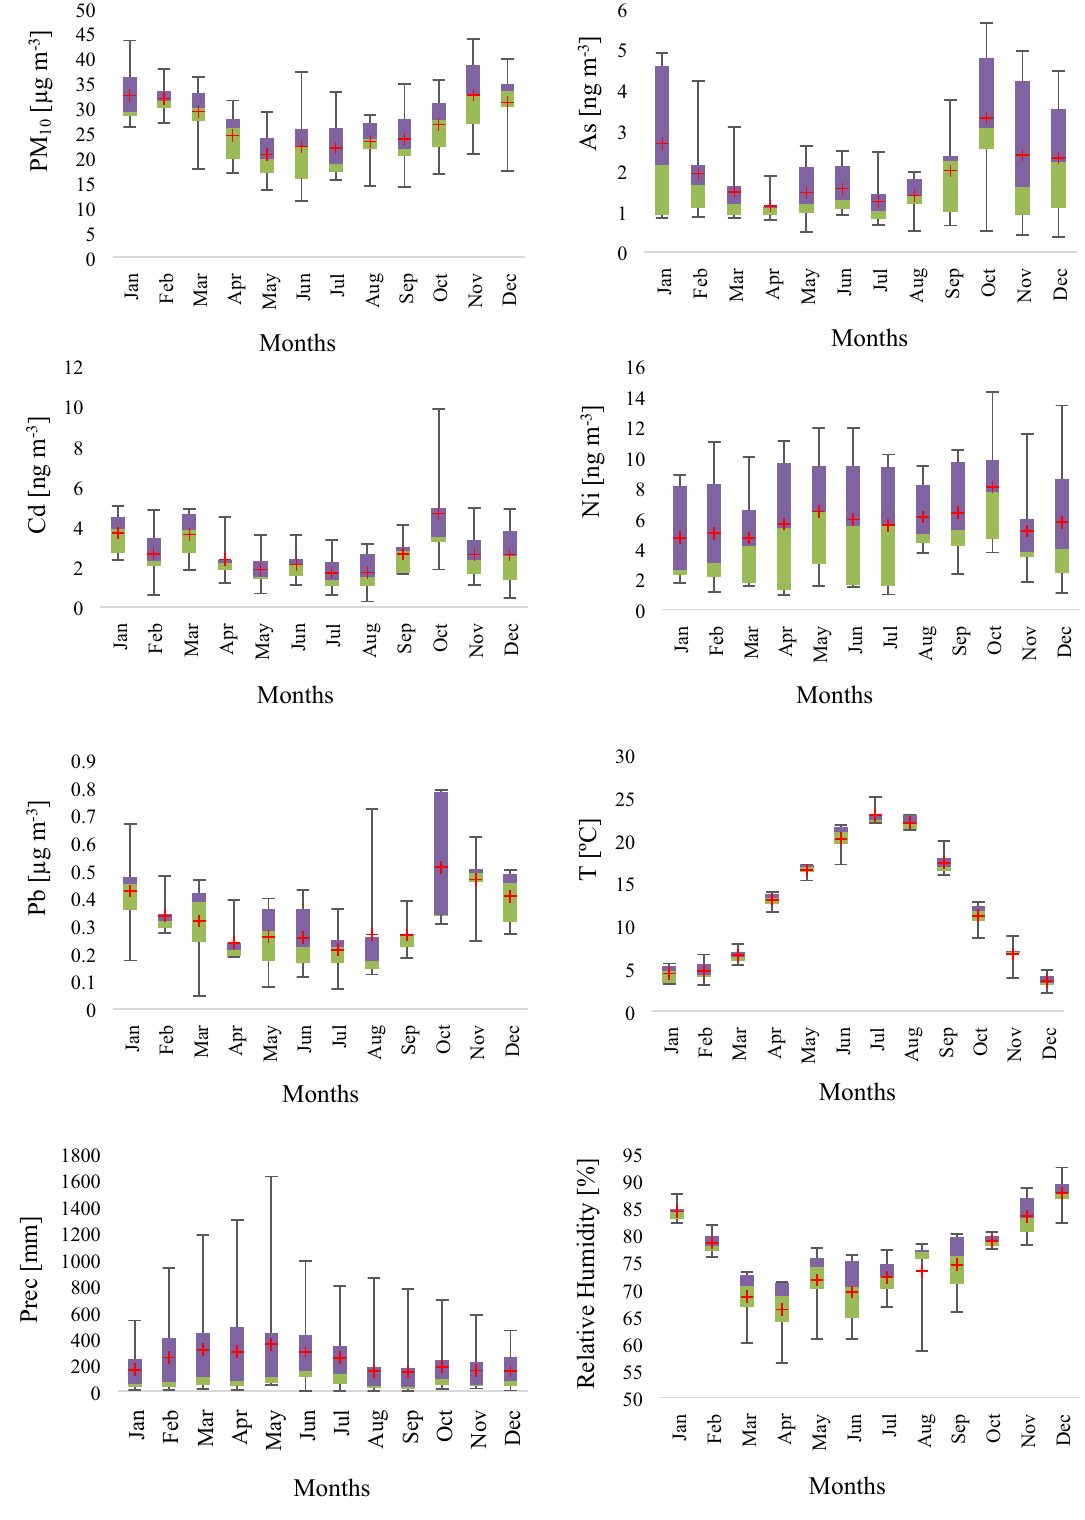
Figure 1. Box-plot analysis of multiannual monthly variations of pollutants and meteorological parameters. The lower (green) and upper (purple) limits represent the first (25P) and third (75P) quartiles, means are represented by red crosses, and the ends of the whiskers represent the minimum and the maximum values. The figures were prepared using the Microsoft Excel